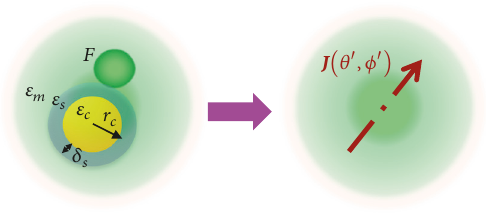
Figure 2: Equivalent between excited target particle and hertzian